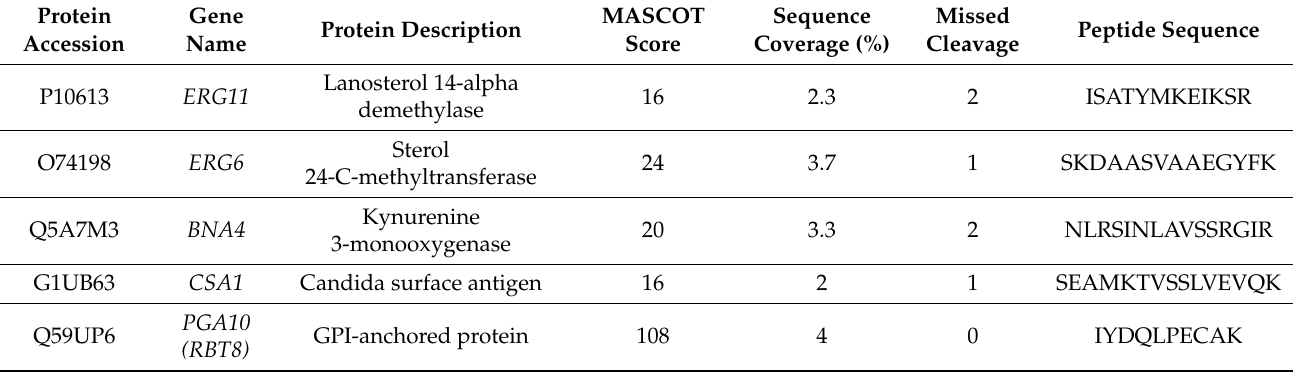
Table 5. Proteins involved in ergosterol biosynthesis and iron acquisition were identified in the fluconazole-resistant C. albicans strain. All proteins were identified using